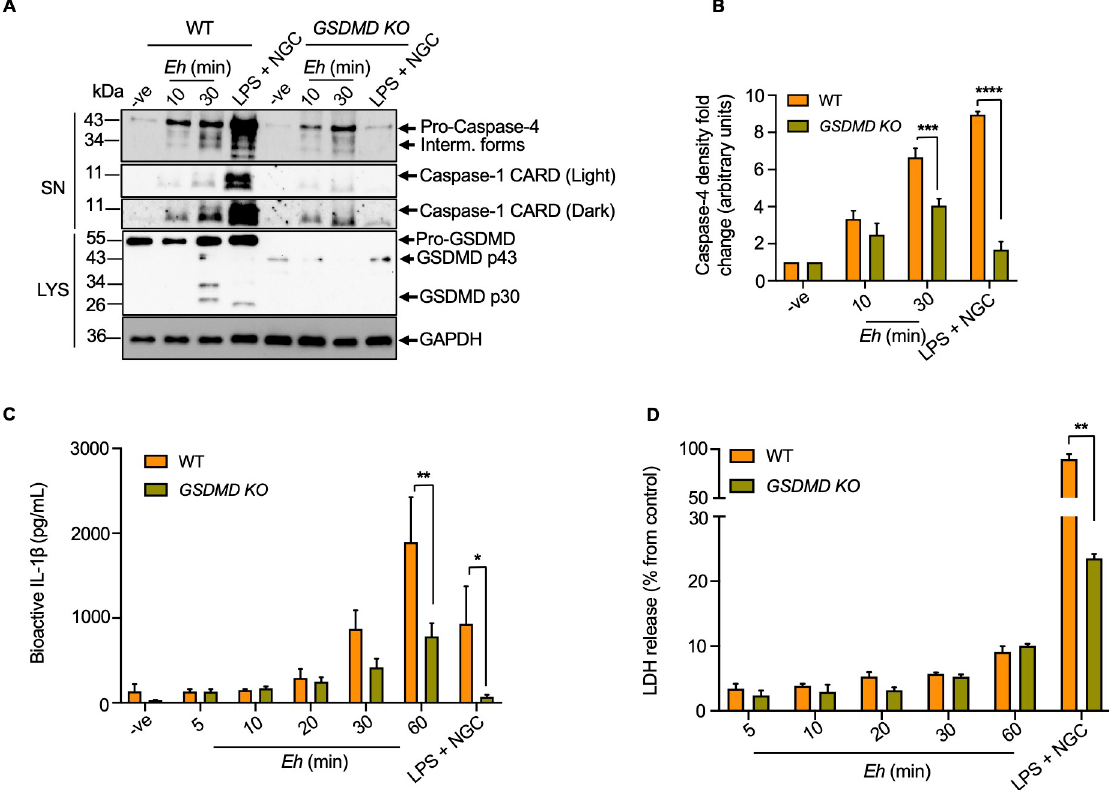
Fig 9. E . histolytica triggered gasdermin D cleavage regulates bioactive IL-1 β release. ( A ) WT and CRISPR/Cas9 GSDMD KO macrophages were incubated with Eh for 10 and 30 min, respectively. LPS (50 ng/mL) and NGC (10 μ M) stimulation for 60 min acted as the positive control. Cell supernatant (SN) was TCA precipitated and cells were washed and lysed. Equal amount of supernatants and lysates (LYS) was resolved on SDS-PAGE and immunoblot analysis was performed for GSDMD, caspase-4 and caspase-1 in both the cell lysates and supernatants, and blots were reprobed for GAPDH. ( B ) Quantifications of active caspase-4 proteins were performed by densitometric analysis from three independent experiments, and the negative (cells only) acted as an internal control. ( C ) Cell supernatant from stimulated macrophages was added to HEK-Blue reporter cells to detect bioactive IL-1 β via the SEAP assay in both WT and CRISPR/ Cas9 GSDMD KO macrophages that were incubated with Eh for increasing amounts of time. ( D ) Cell death was determined by LDH assay using supernatant from stimulated macrophages, and is shown as a percentage of LDH release compared to non-stimulated cells (control). Data and immunoblots are representative of three separate experiments (n = 3) and a one-way ANOVA was used to determine statistical significance of differences between WT and GSDMD KO cells at each treatment time ( � p < 0.05, �� p < 0.01, ��� p < 0.001, ���� p < 0.0001). Bars represent mean ±